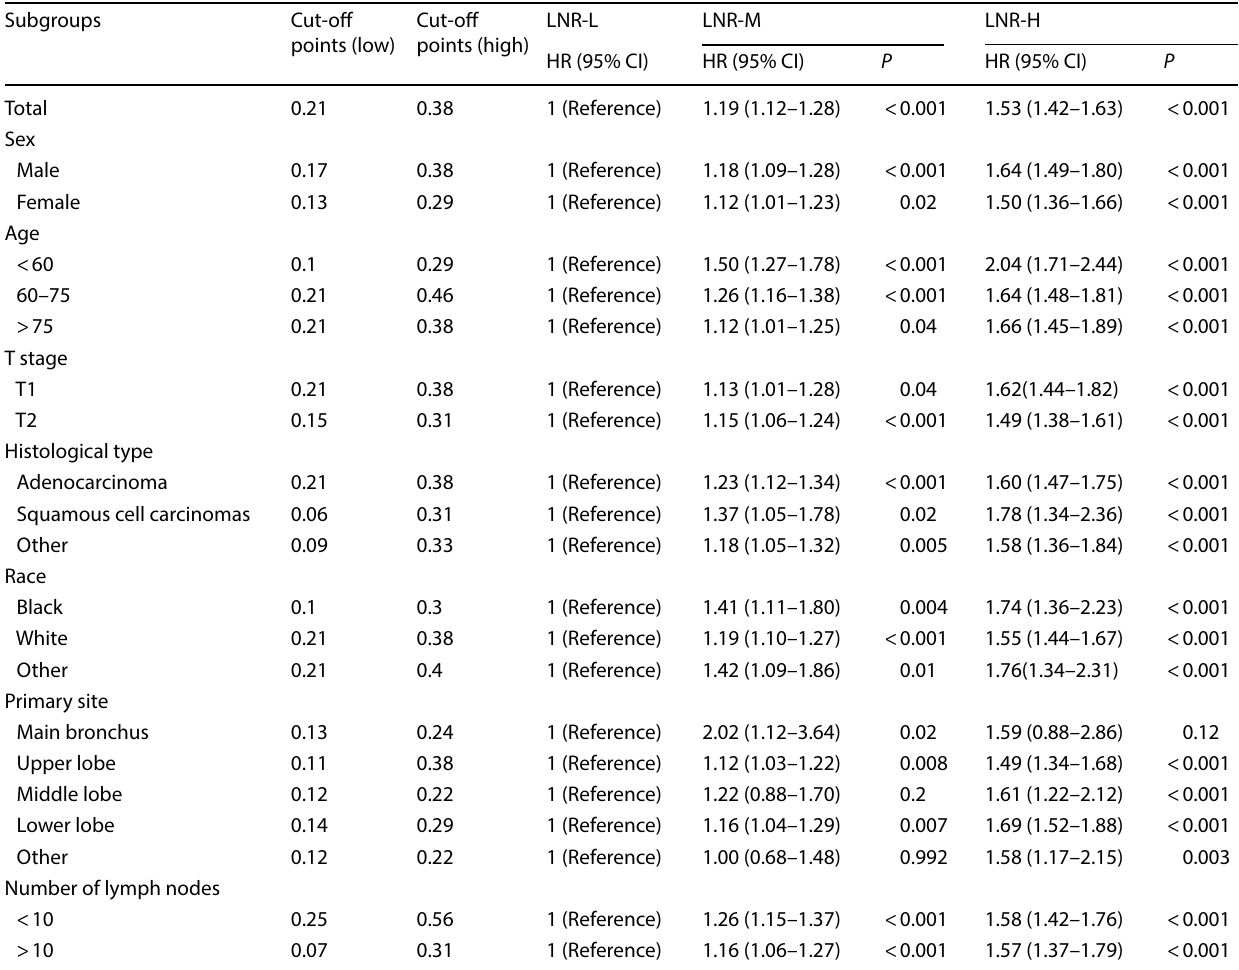
Table 2 The univariate multi-subgroup Cox regression model of LNR